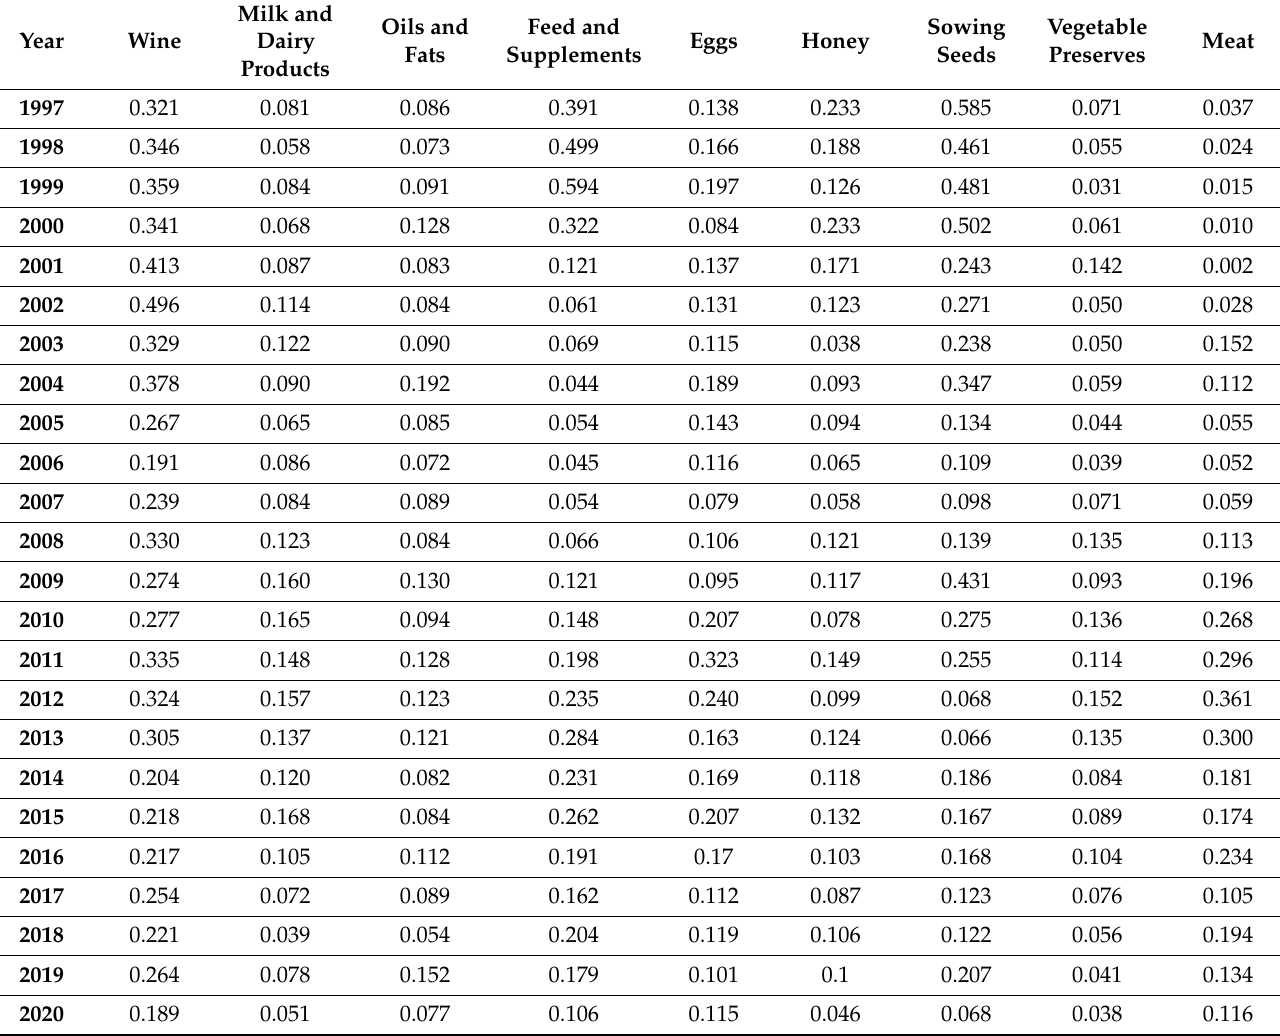
Table 3. Dispute rates for sector and